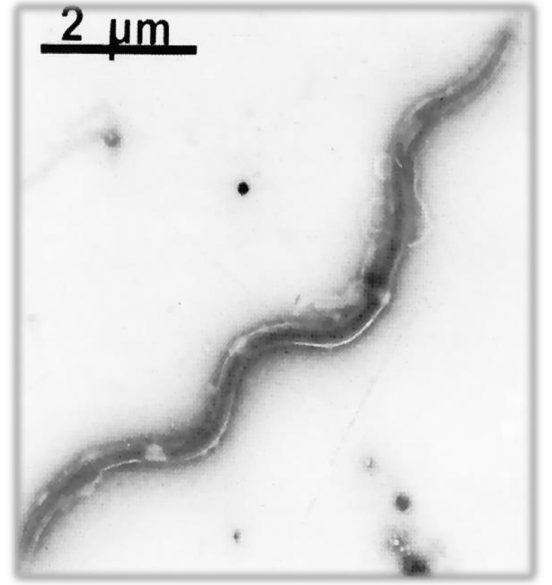
Figure 6. Transmission electron microscopy (TEM) image of Borrelia Lyme group, Borrelia garinii , BITS (Borrelia Italy Trieste strain) [146] (photo by M.